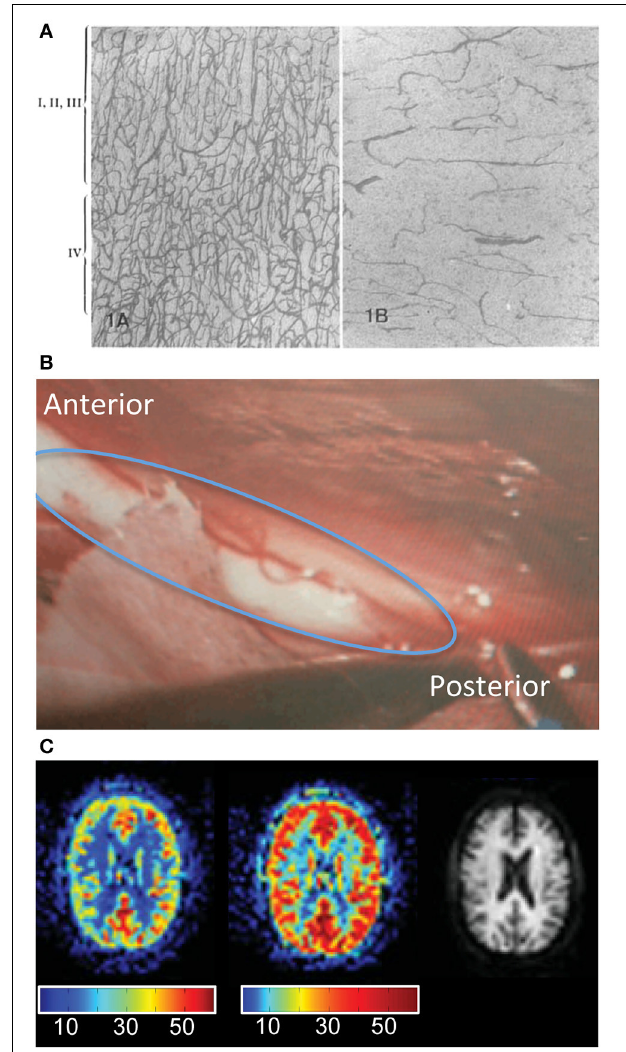
FIGURE 1 | The vasculature and perfusion of the white matter of the human brain. (A) Capillary density for various layers of the cortex (left panel) compared to white matter (right panel). Fixed human brains were embedded in paraffin, sectioned (10 microns) and stained by means of Goldner’s trichrome-method (reproduced with permission; Lierse and Horstmann, 1965). (B) Blood vessels on the surface of the corpus callosum (circled in blue). Photo captured during neurosurgery for corpus callosotomy (photo credit: R. D’Arcy). (C) Detection of white matter perfusion with arterial spin labeling MRI. Cerebral blood flow maps with different scale bars in order to better view gray matter perfusion (left) and white matter perfusion (middle). The right image shows the anatomy for reference (reproduced with permission; Van Osch et al.,